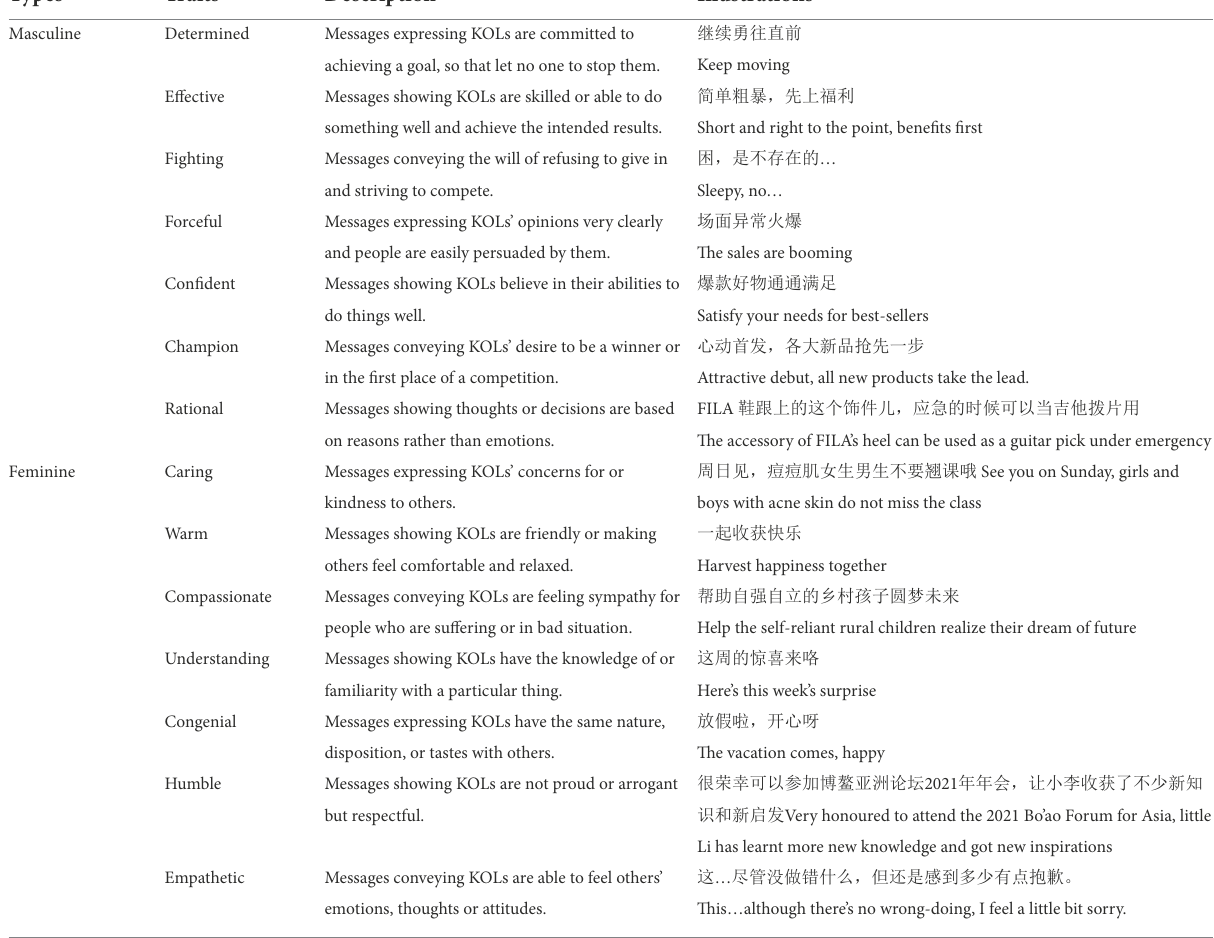
TABLE 2 Coding scheme for personality